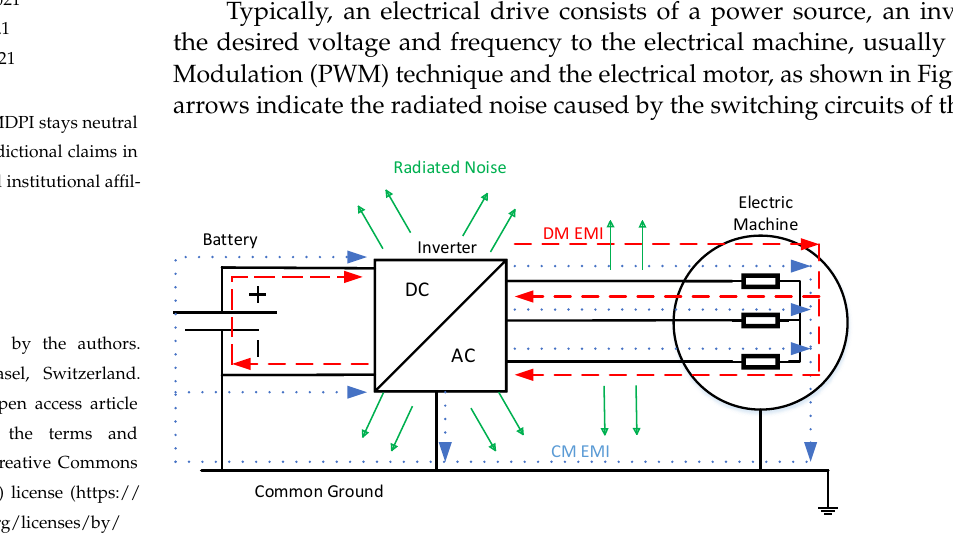
Figure 1. Radiated and Conducted Electromagnetic Interference (EMI) in an electric